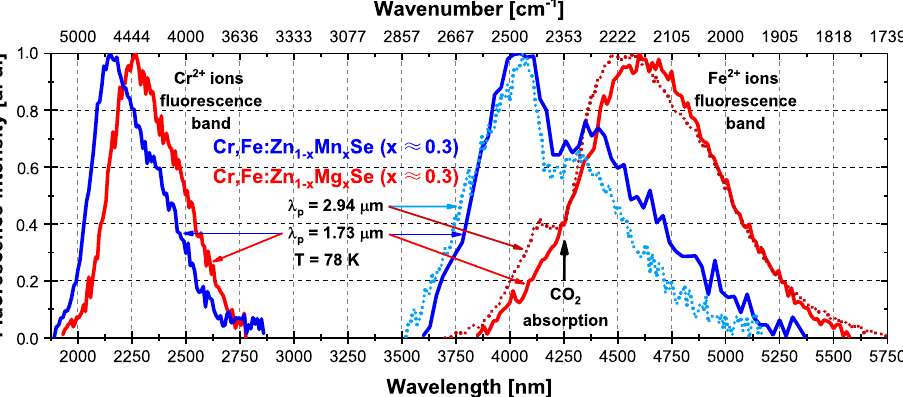
Figure 3. Fluorescence spectra of the Cr 2 + and Fe 2 + ions of Cr,Fe:Zn 1 − x Mn x Se (x ≈ 0.3) (blue) and Cr,Fe:Zn 1 − x Mg x Se (x ≈ 0.3) (red) crystals at a temperature of 78K measured under direct excitation (full lines) and directly pumped Fe 2 + ions at 2.94 µ m (dotted